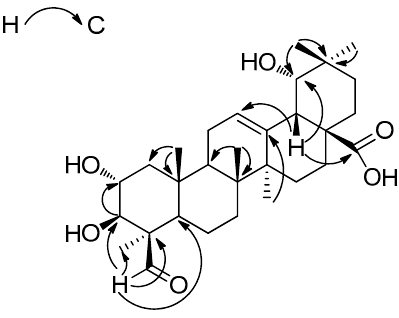
Figure 2. Key HMBC correlations of compound 1 (from H to C).